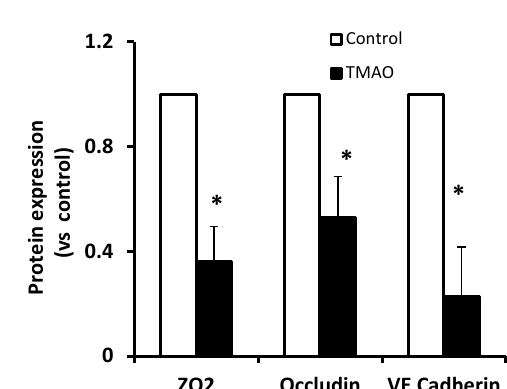
Figure 1. E ff ects of trimethylamine-N-oxide (TMAO) on tight junction proteins ZO-2, VE-Cadherin, and Occludin in EOMAs. Representative ( A ) confocal images ( n = 5), ( B ) summarized data shows the fluorescence intensity and ( C ) Western blot ( n = 6) show the ZO-2, VE-Cadherin, and Occludin expression in EOMAs with or without stimulation of TMAO. * significant di ff erence from